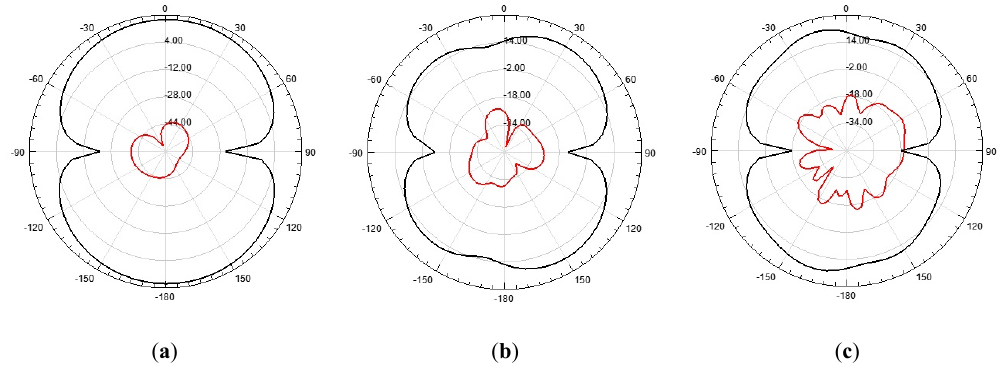
Figure 10. Bio-inspired PMA E-plane co-polarization (black) and cross-polarization (red) radiation Figure 10. Bio ‐ inspired PMA E ‐ plane co ‐ polarization (black) and cross ‐ polarization (red) radiation patterns, respectively: ( a ) 350 MHz; ( b ) 900 MHz; ( c ) 1500 patterns, respectively: ( a ) 350 MHz; ( b ) 900 MHz; (c) 1500 MHz.